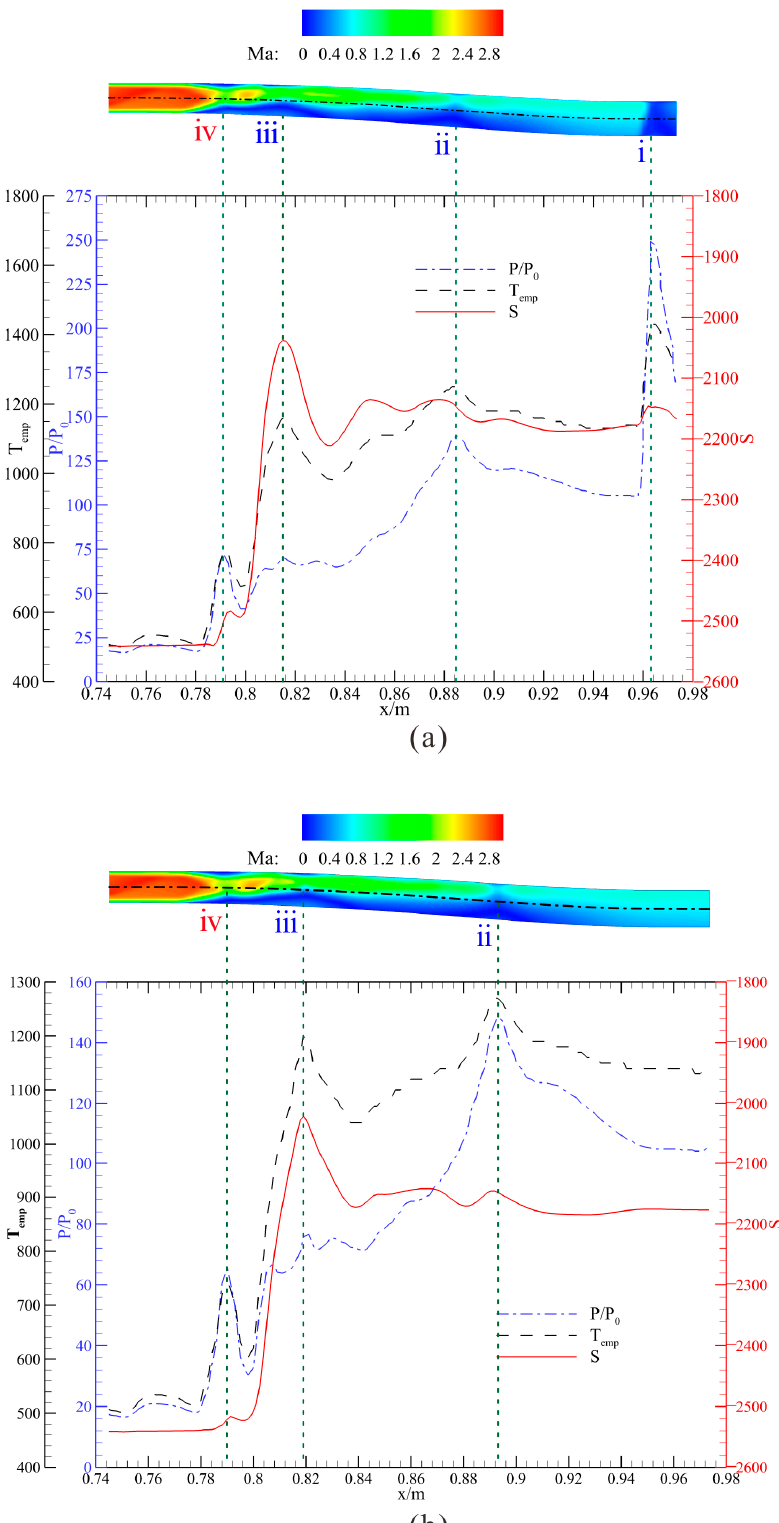
Figure 11. Entropy profile of the sectional centerlines along the axial direction. ( a ) θ = 135°. ( b ) θ = 180°.